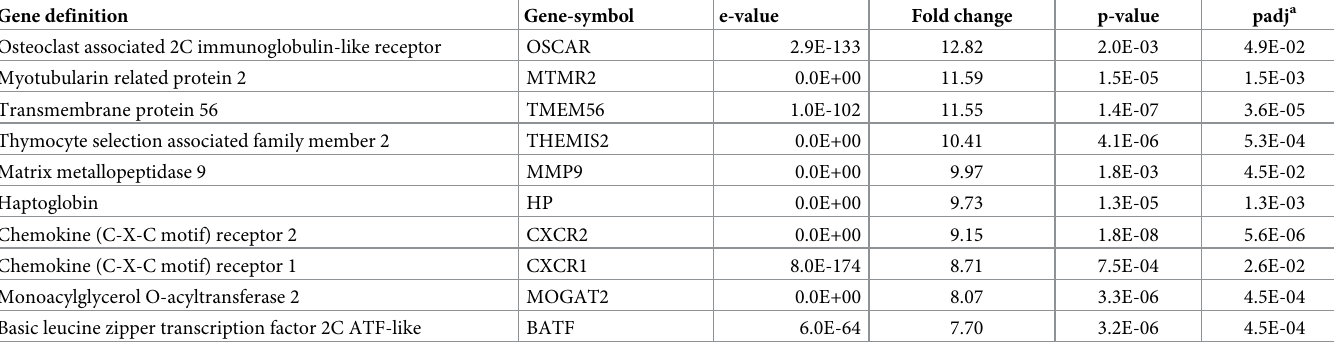
Table 2. Top 10 upregulated genes of Florida manatees exposed to red tide as compared to the experimental control group.